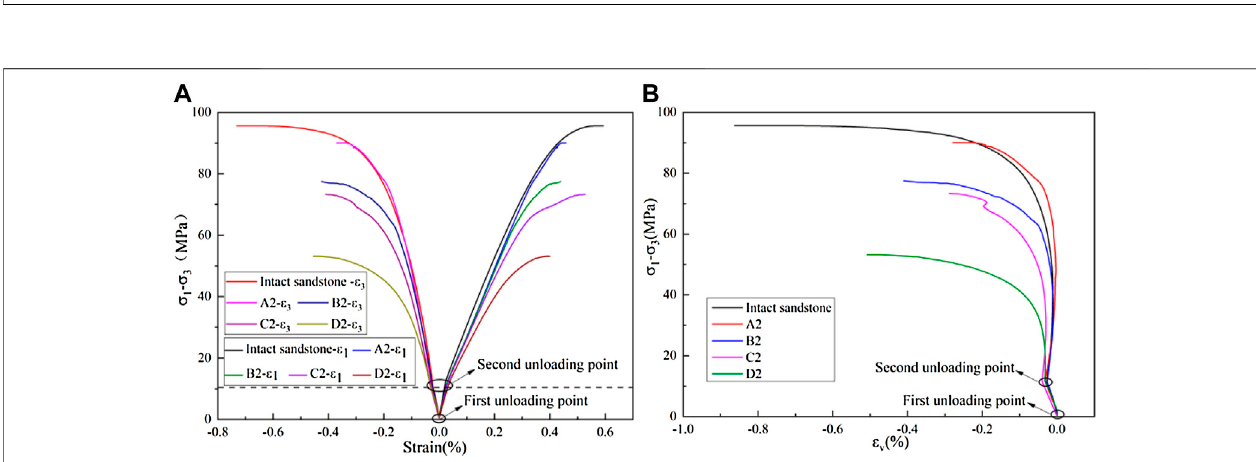
FIGURE3| Stress-straincurveofsandstonesampleswithdifferentcracklengthsandanintactsample: (A) deviatorstressvsminimumprincipalstrain; (B) deviator stress vs volumetric strain (A2, 60 ° , 10 mm; B2, 60 ° , 15 mm; C2, 60 ° , 20 mm; D2, 60 ° , 25 mm; B0, 0 ° , 15 mm; B1, 30 ° , 15 mm; B3, 90 ° , 15 mm).